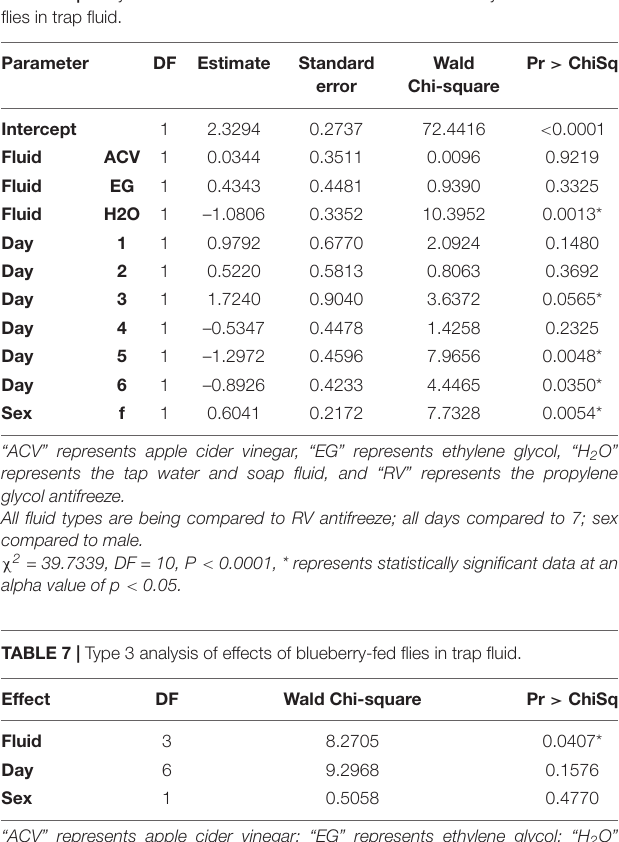
TABLE 6 | Analysis of maximum likelihood estimates of blackberry fed flies in trap fluid.